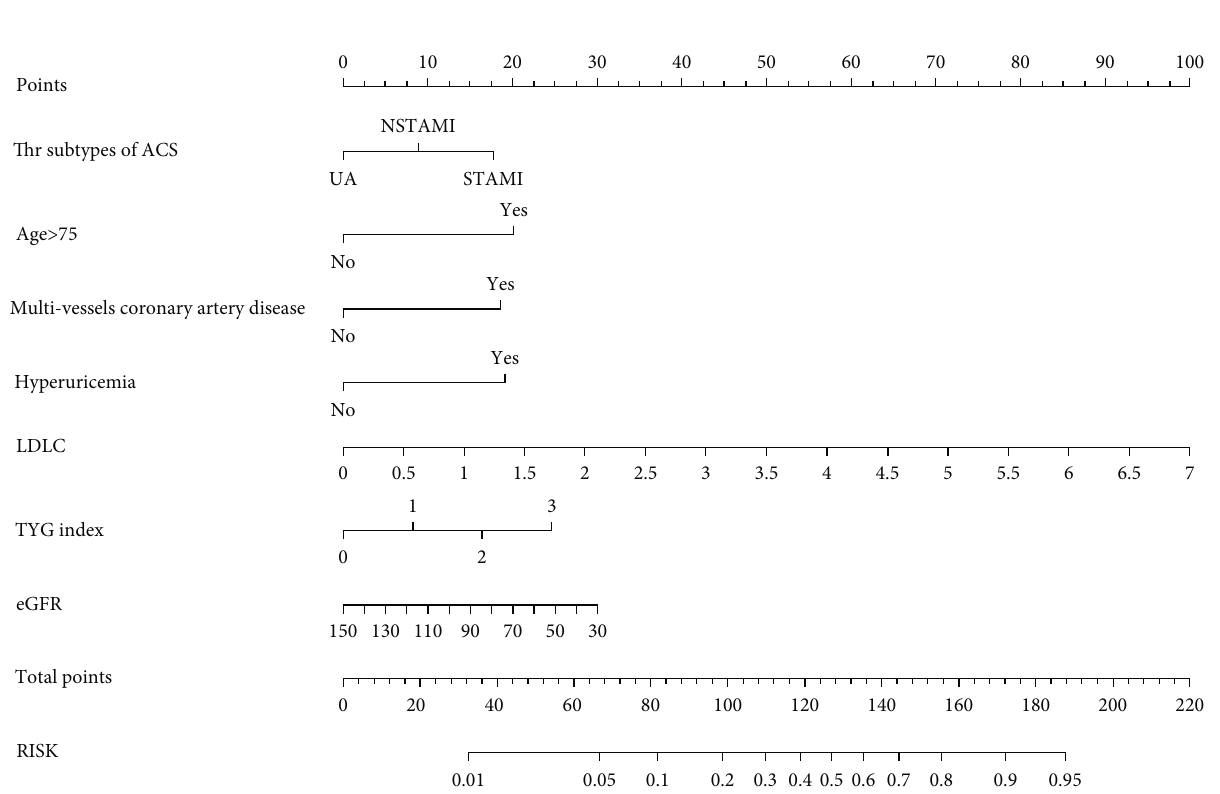
Figure 3: Nomogram used for predicting CI-AKI in patients with ASCVD and diabetes mellitus. Abbreviations: ACS: acute coronary syndrome; UA: unstable angina; STAMI: ST-segment elevation myocardial infarction; NSTAMI: non-ST-segment elevation myocardial infarction; LDL-C: low-density lipoprotein cholesterol; TyG: triglyceride-glucose; eGFR: estimated glomerular fi ltration rate.